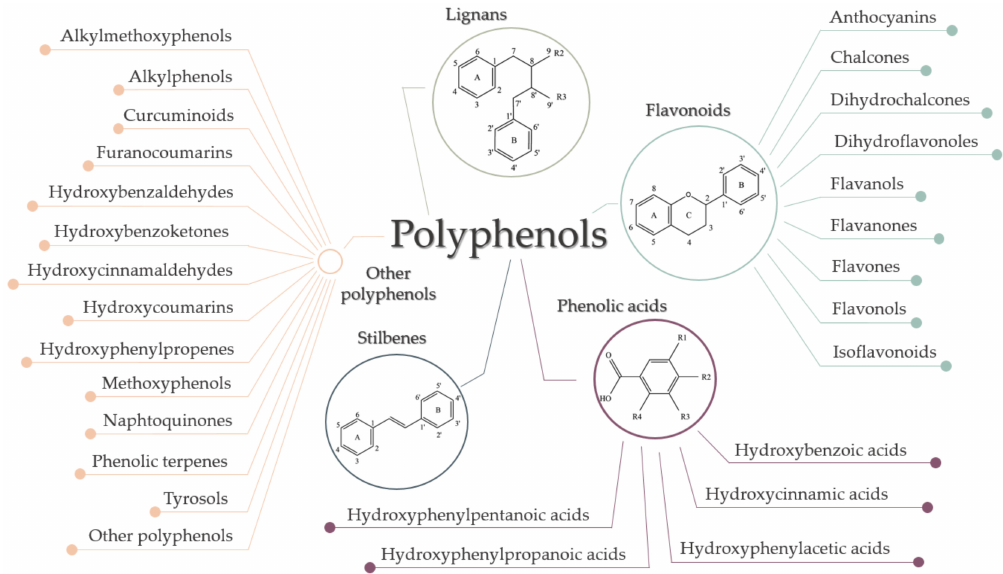
Figure 5. Classification of